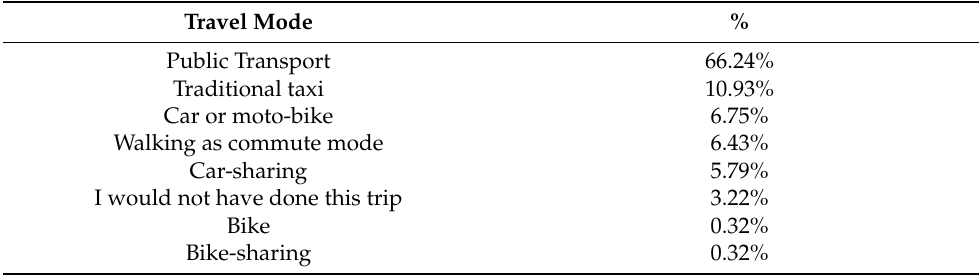
Table 6. Survey responses to “What mode(s) of transportation would you have taken if TNC was not available for this trip?” (N = 311, % of all TNC users).